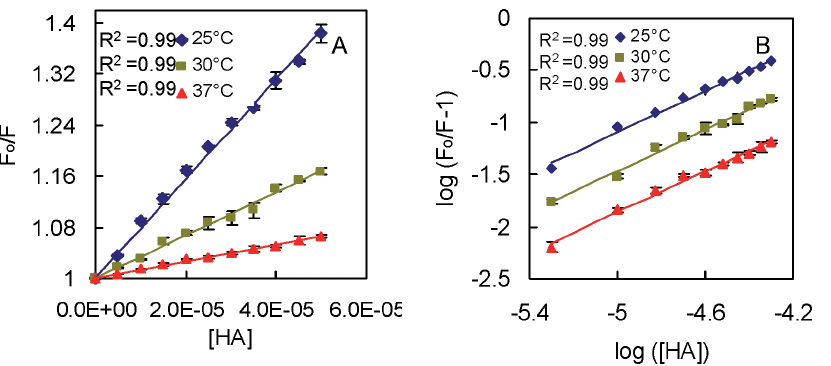
Figure 2. Stern—Volmer (A) and log[(F 0 -F)/F] versus log[HA] (B) plot at different temperatures. Protein (5 m M) was excited at 295 nm.